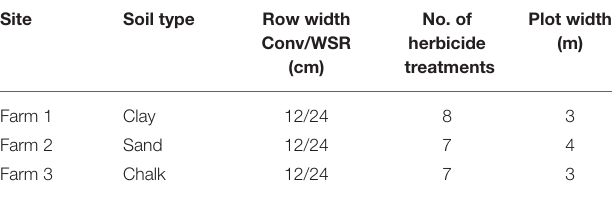
TABLE 1 | Experimental design for study 2.